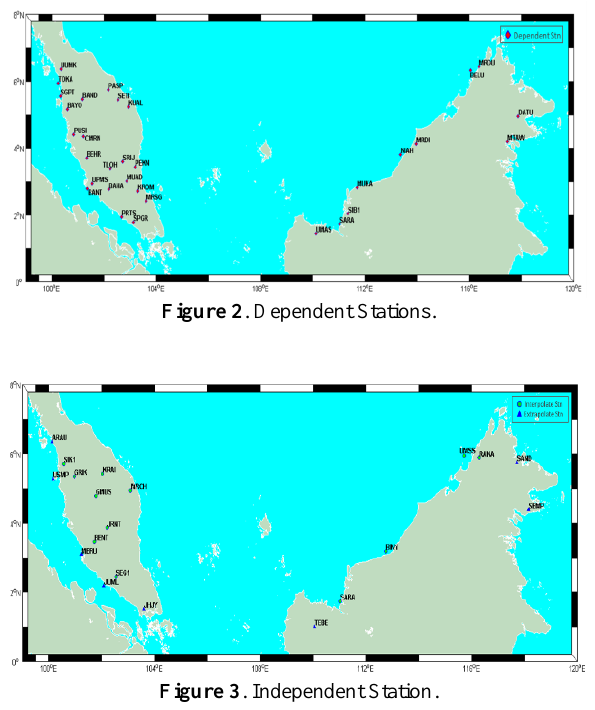
Figure 3 . Independent